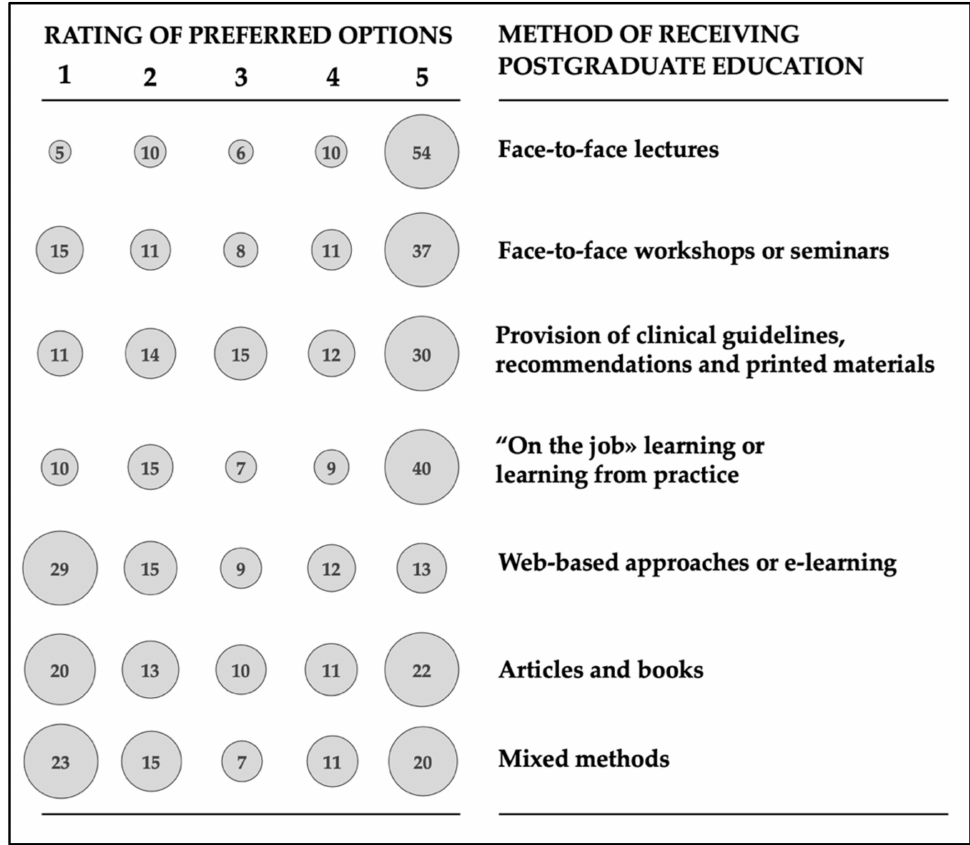
Figure 3. Ratings (1—lowest, 5—highest) for preferred method of receiving postgraduate antimi- crobial stewardship education and training. Percentages are depicted above each column, all the remained respondents (up to the total of 100%) did not rate the option during the